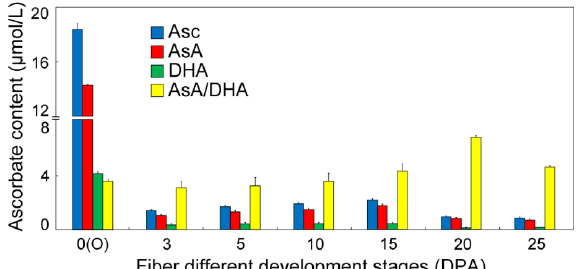
Figure 1. Determination of L-ascorbate (Asc) content and ascorbic acid/dehydroascorbic acid (AsA/DHA) ratio during the fiber development stages. The materials at 0 days post-anthesis (DPA) ovules and the presented ovules ’ associated fibers at different development stages were collected for the measurement of Asc content and calculation of the AsA/DHA ratio. Error bars represent the standard error from three independent experiments.